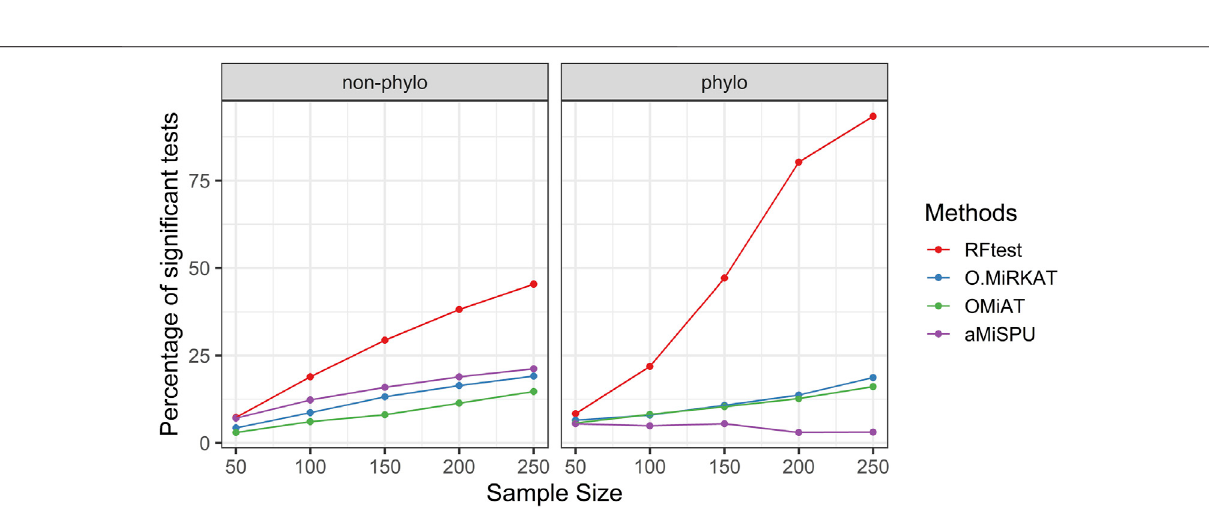
Frontiers in Genetics |